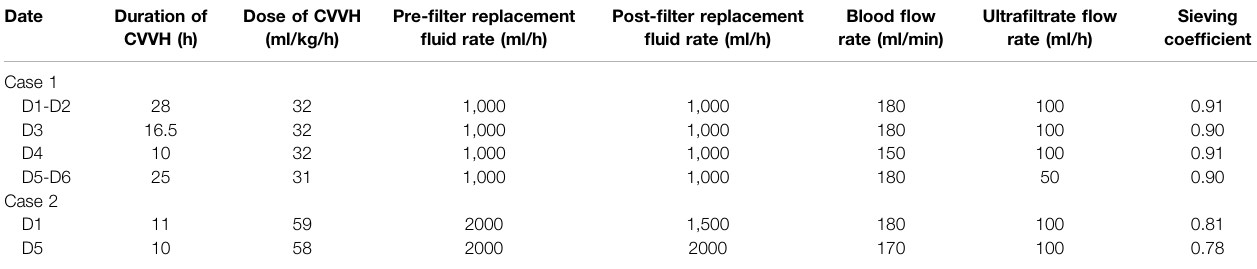
TABLE 1 | Parameters of CVVH during treatment with vancomycin.